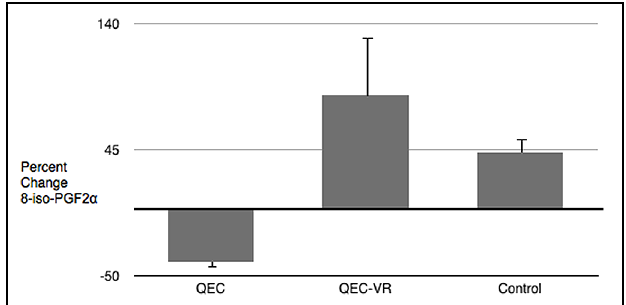
FIGURE 2 | Pre- and post-study change in oxidative stress (8-iso-PGF2 α ). Presented in percent change from baseline. Mean ±